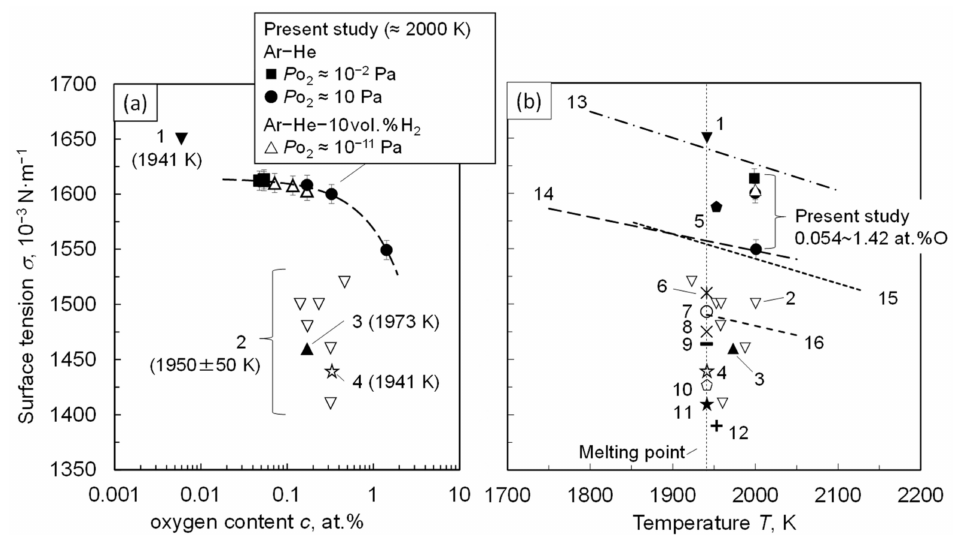
Figure 2. Surface tension of liquid titanium measured by EML at about 2000 K with respect to the oxygen content ( a ) and its comparison with a scatter of literature data ( b ) [1–16].